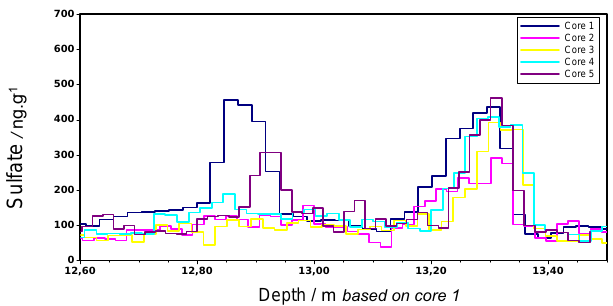
Figure 8. Close look at UE 1809 and Tambora (1815) events show- ing the absence of the Tambora event in two out of the five cores. This figure illustrates the possibility of missing major volcanic erup- tions when a single core is